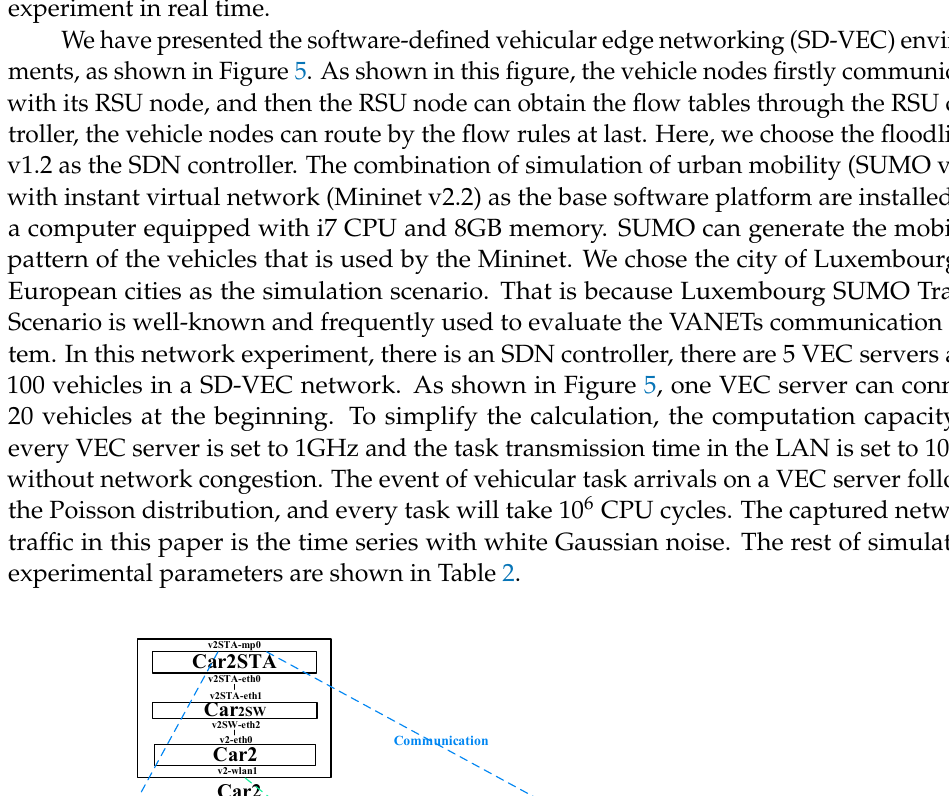
Wireless Connections Figure 6. Network topology of the experiment. As shown in Figure 7, the initial average CPU utilization of the edge servers 1 to 4 is 20% and CPU utilization of the edge server 5 is 90%. The initial average memory utiliza- tion of the edge servers 1 to 4 is 25% and memory utilization of the edge server 5 is 100%. The initial average disk utilization of the edge servers 1 to 4 is 23% and memory utilization of the edge server 5 is 93%. The total experiment duration is 1000 s. The experiments show